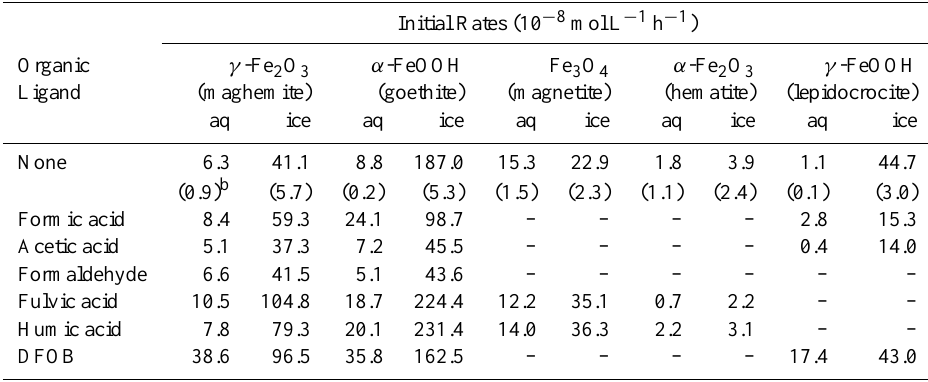
Table 2. Initial dissolution rates of different iron oxides in the presence and absence of various organic ligand a .